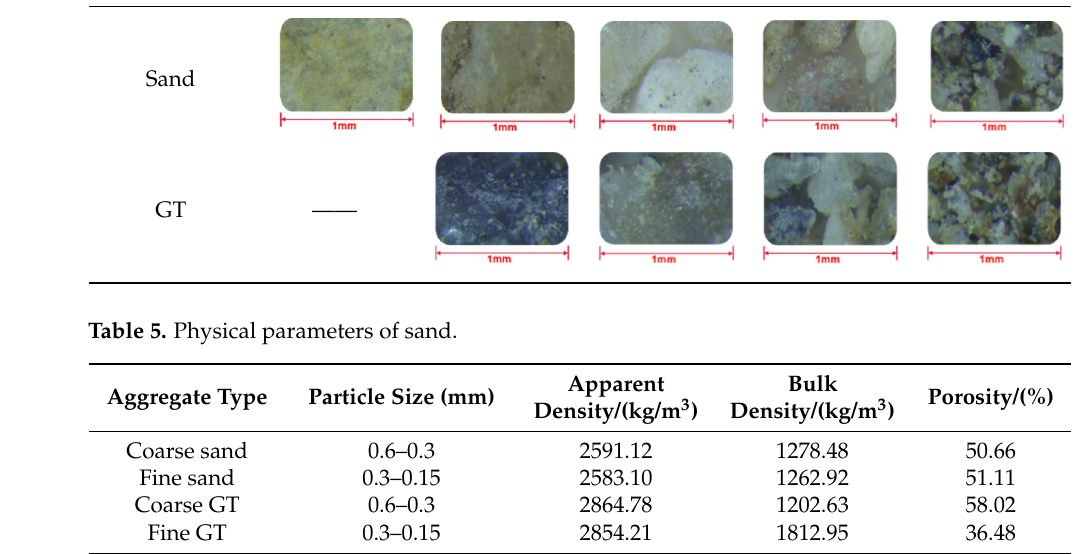
Table 5. Physical parameters of sand.